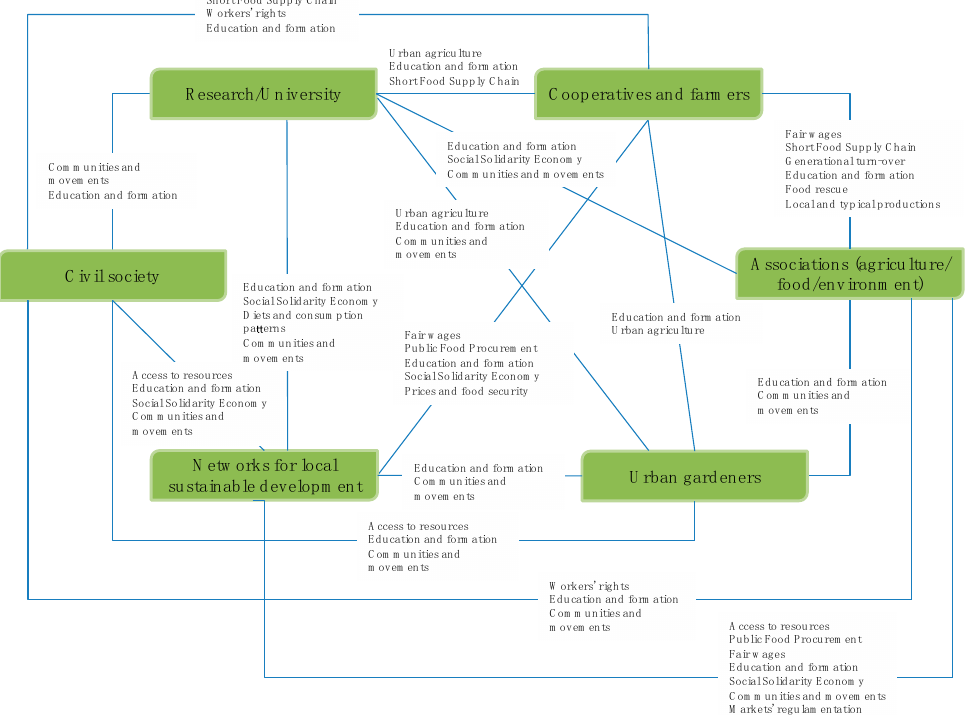
Figure 4. Conceptual map of the actors and themes. The themes common to each pair of clusters are in order of relevance from top to bottom (Source: own elaboration).